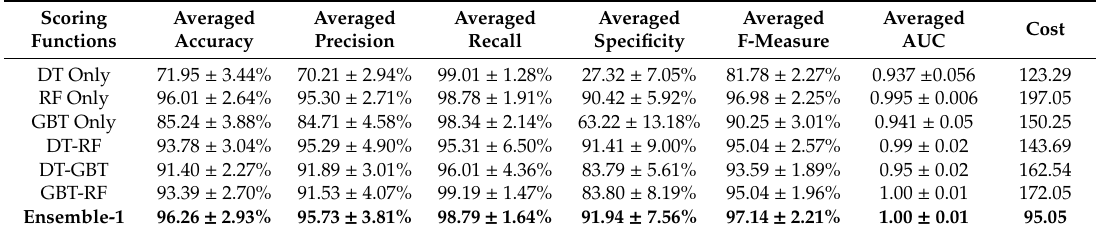
Table 11. Multiple combinations of scoring functions and their respective results.